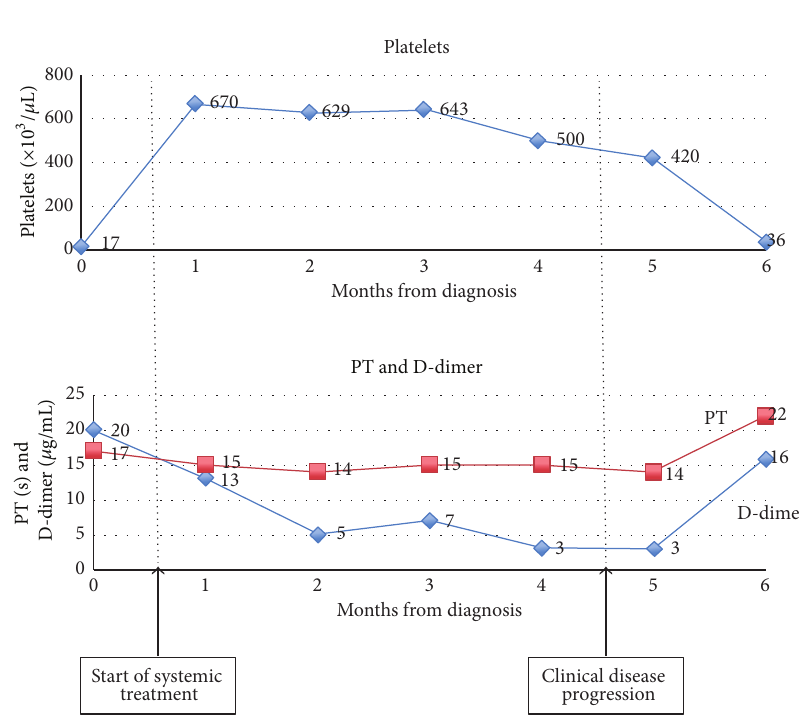
Figure 1: Variation in hematological and coagulation parameters showing coagulopathy at diagnosis that improved with therapy but recurred at disease relapse.